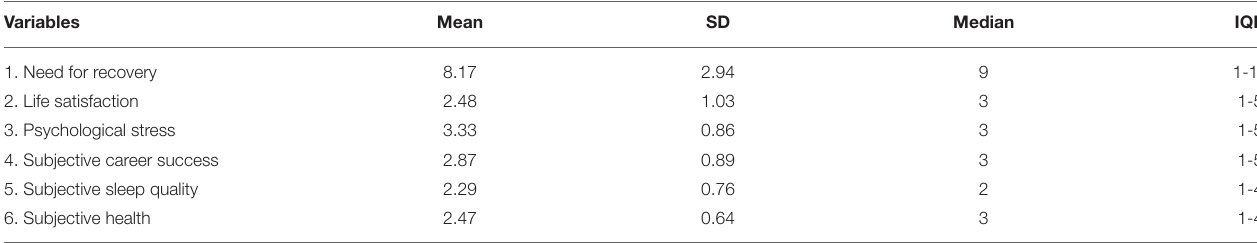
TABLE 2 | The information of distribution of each